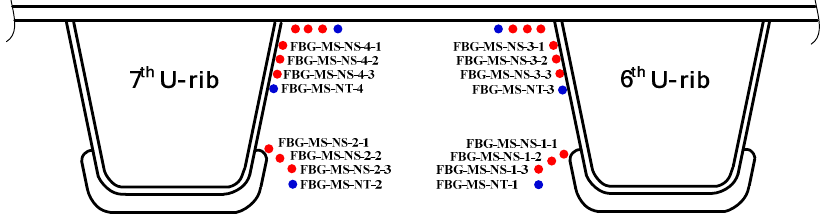
Figure 3. Deployment of FBG sensors.